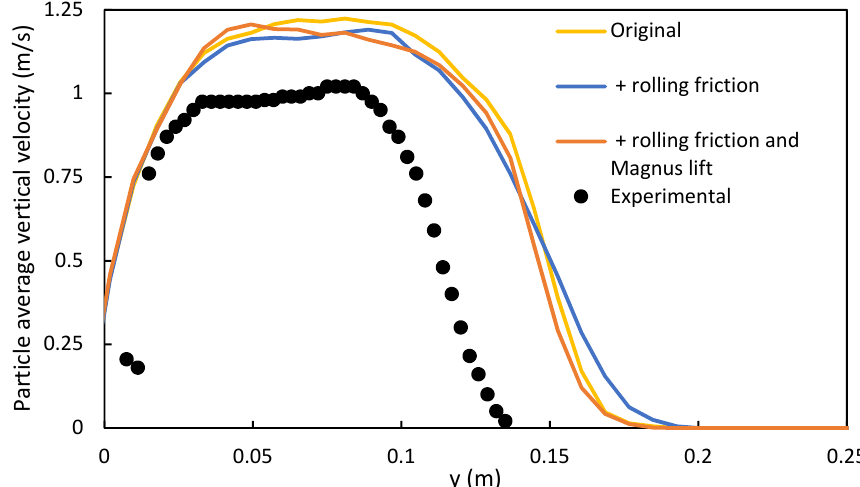
Figure 4. Time-averaged vertical profiles of the particles’ vertical velocity in MFiX, including addi- tional forces.